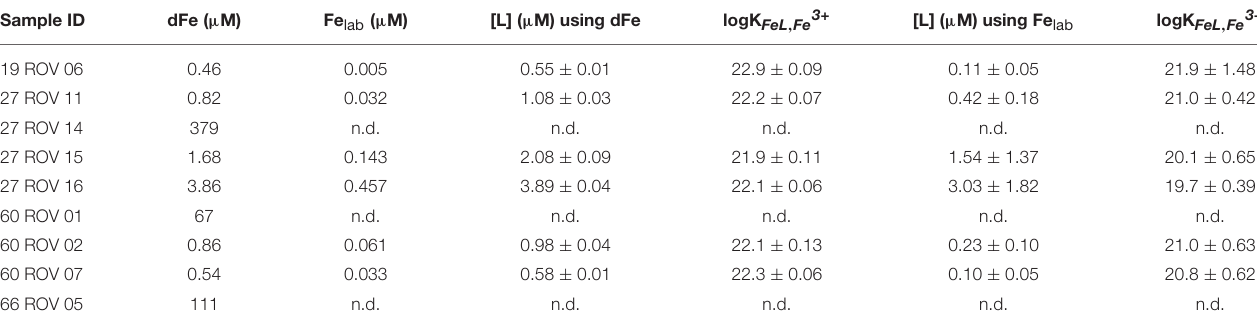
TABLE 4 | Comparison of the different calculated ligand characteristics [L] and logK FeL , Fe 3+ for all ROV samples using dFe or Fe lab as initial iron concentrations. Sample